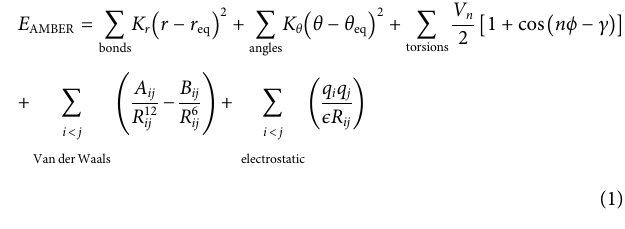
FIGURE 1 | The general workflow for predicting RNA 3D structures using CG